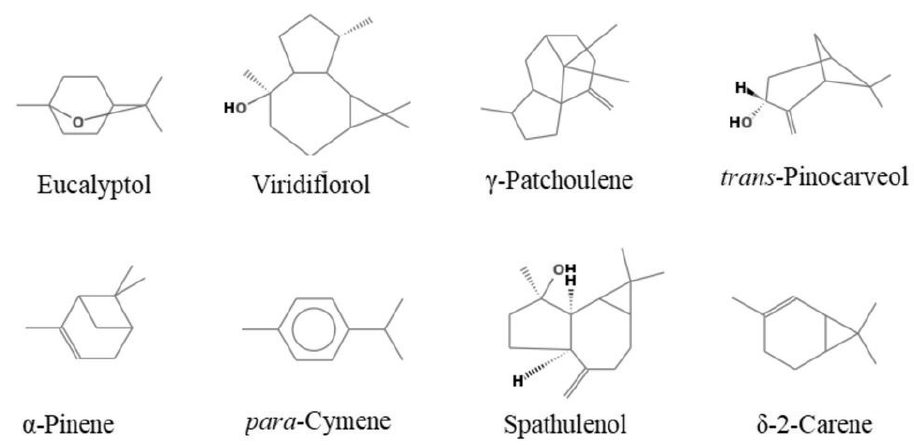
Figure 1. Main components of the analyzed essential oils.